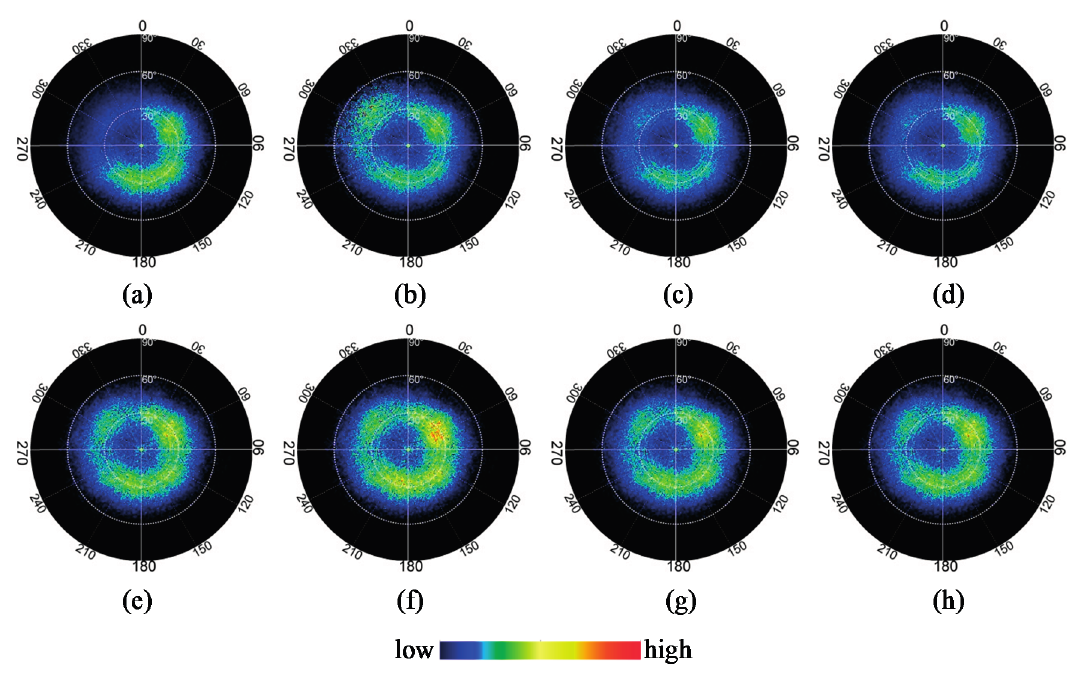
Figure 3. The reflectance intensity distribution of band 4 from different topographic correction methods for different slope (denoted by the radius) and aspect angles ( a – h ). The upper row is the for spring TM sub-scene and its correction results from different methods; the lower row is for the autumn TM sub-scene and its correction results from different methods, therein, first column for the original images, second column for the correction results by Sandmeier model, third column for the correction results by Li model, forth column for the correction results by the model proposed,